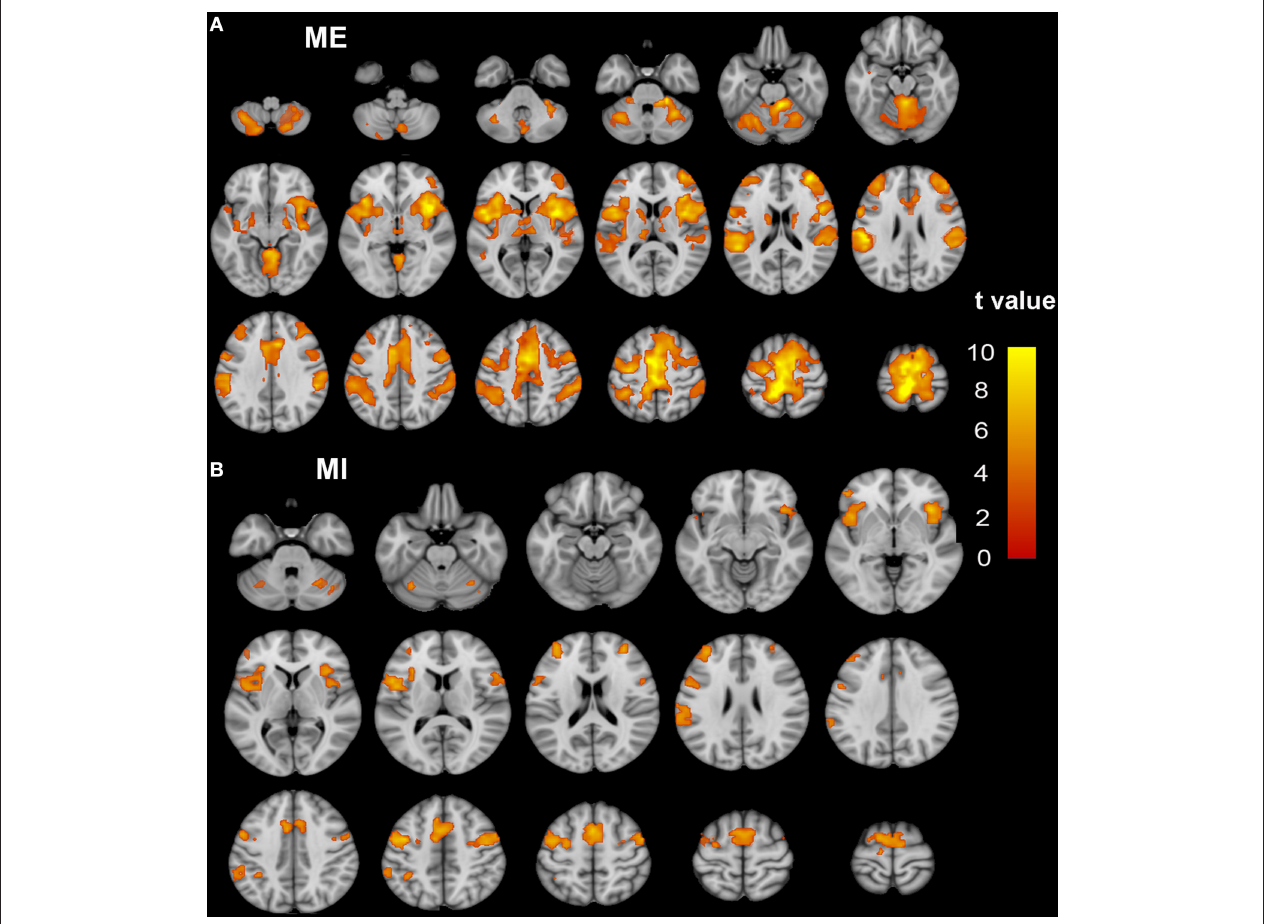
FIGURE 1 | The activation patterns of the ME and MI tasks in the NC group. Typical brain regions with activation during an ME task are shown in (A) , while brain regions with activation during an MI task are shown in (B) . Significant activation is considered to correlate to a voxel-wise threshold of q < 0.01 (FDR correction) and a cluster ≥ 30 voxels. The right side of the image corresponds to the right hemisphere. The color bar represents the t -values. ME, motor execution; MI, motor imagery; NC, normal controls.